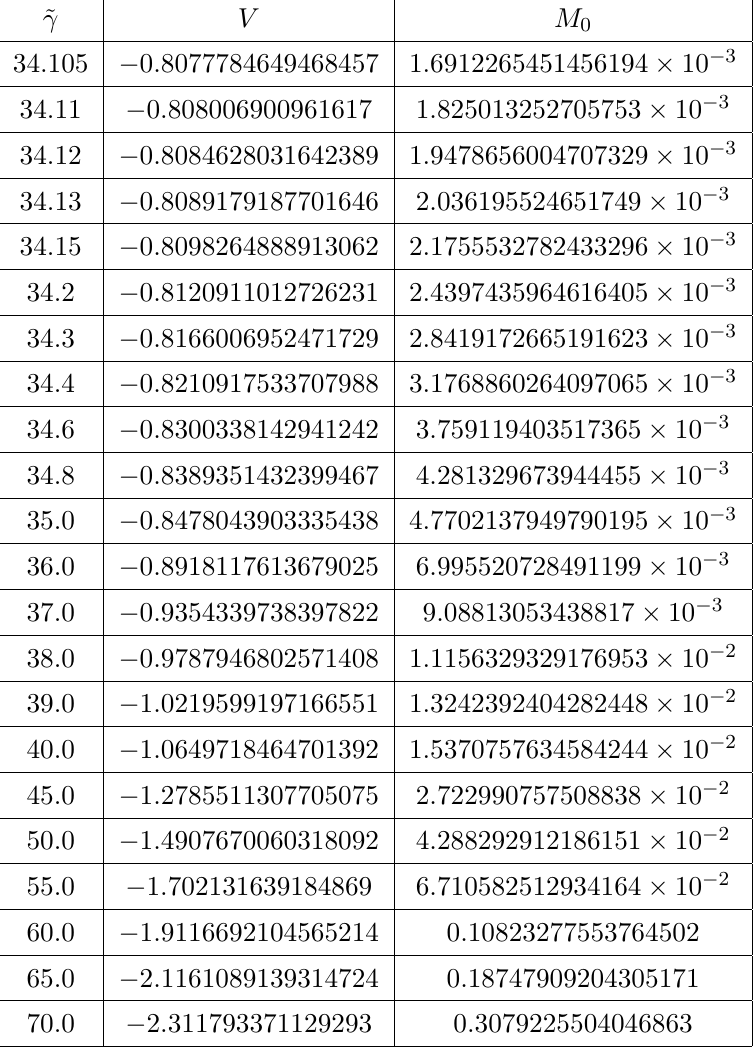
Table 2. N = 30 , partial phase, θ = 0